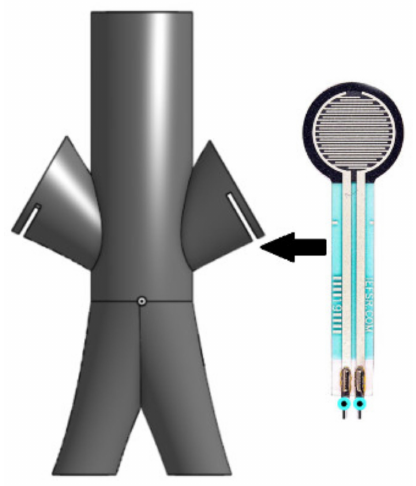
Figure 22. FSR connector design and